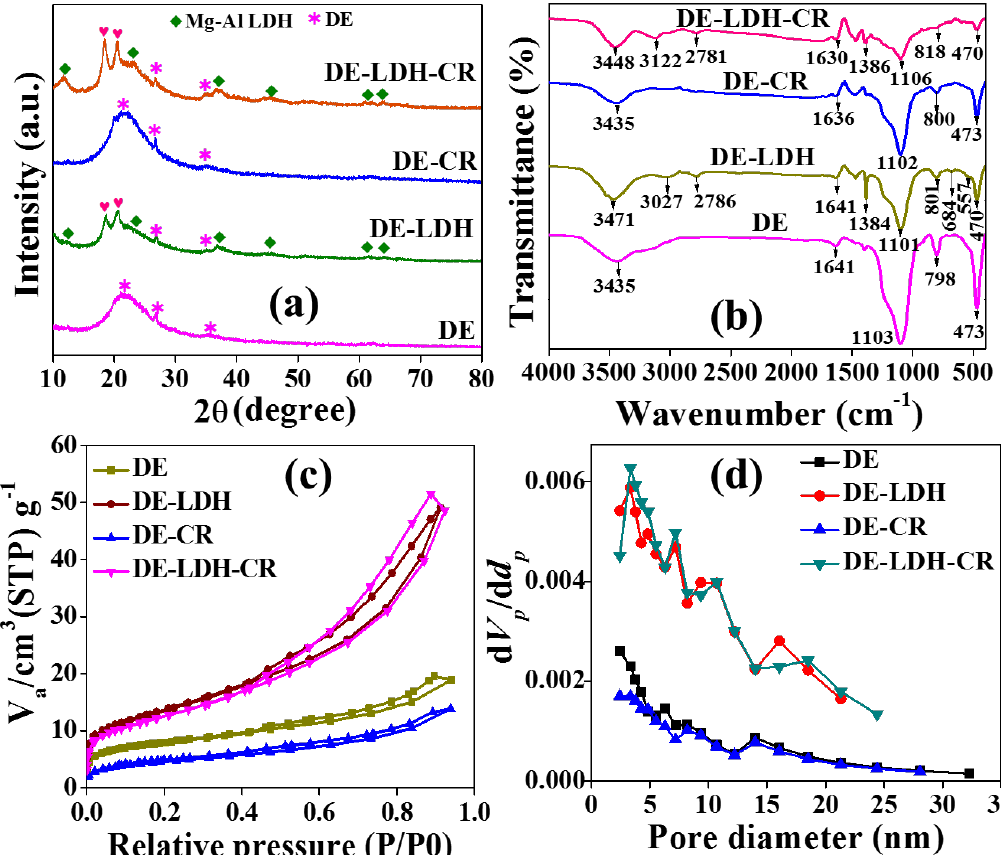
Figure 3. Characterization of DE and DE-LDH (before dye adsorption) and DE-CR and DE-LDH-CR (after dye adsorption) by (a) XRD pattern, (b) Fourier transform infrared spectroscopy (FTIR)